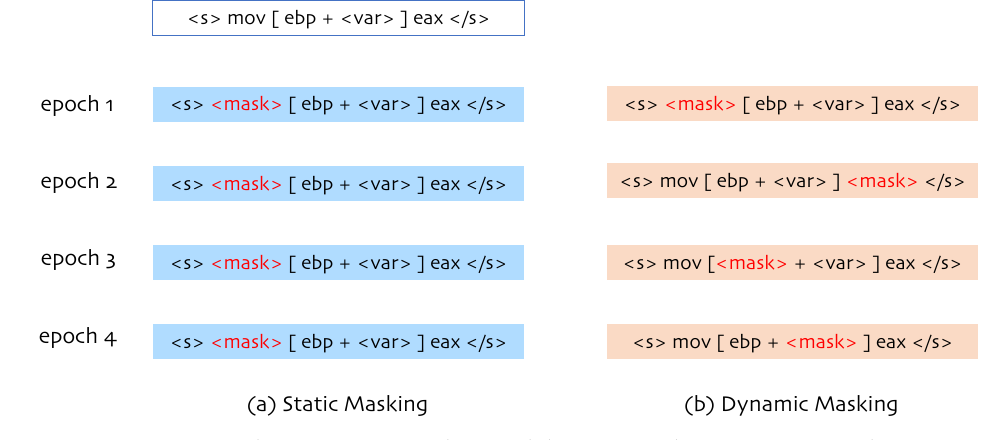
Figure 4. Comparison between static masking and dynamic masking. Dynamic masking can mask more positions than static masking.